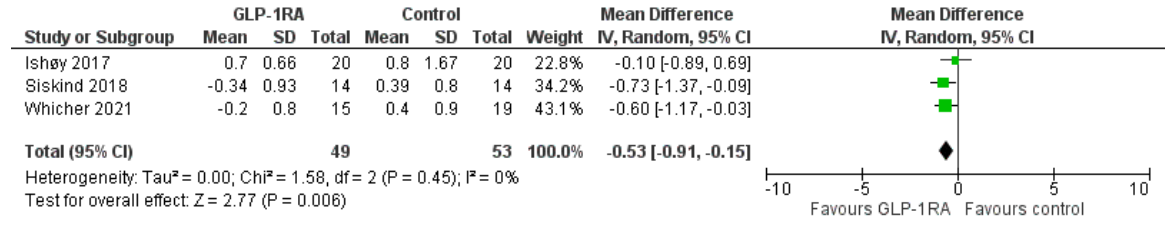
Figure 5. Effect of GLP-1RAs compared to control on fasting plasma glucose among individuals treated with antipsychotic drugs.